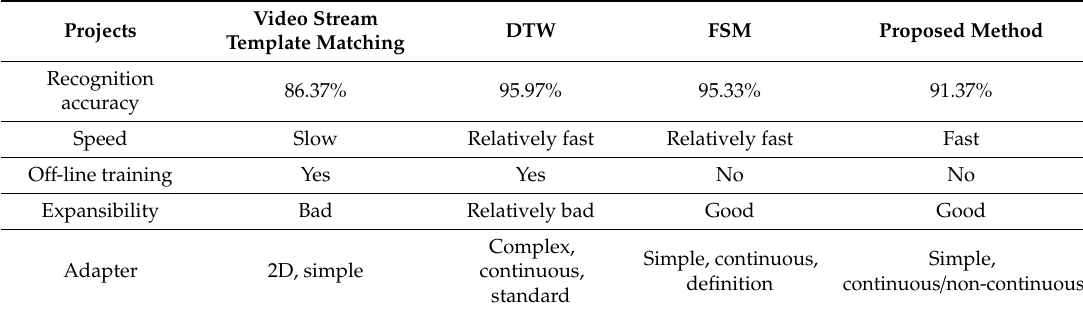
Table 5. Performance comparison of di ff erent recognition algorithms; DTW (Dynamic Time Warping), FSM (Frequent Subgraph Mining)